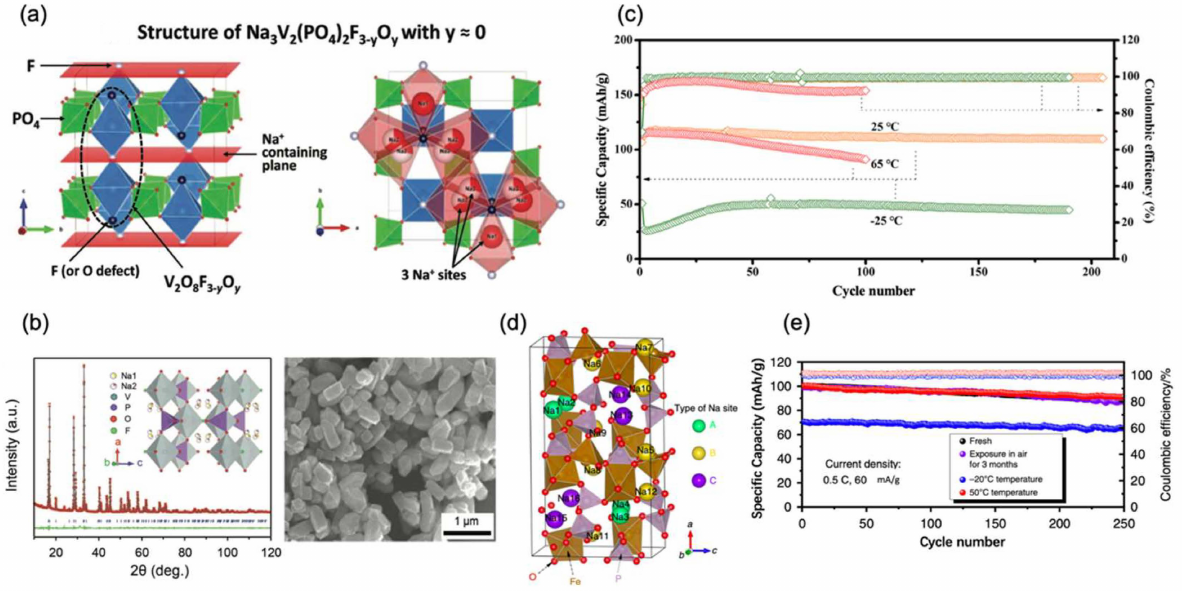
Figure 4. ( a ) On the left, the 3D schematic illustration of NVPF 3 − y O y . The black dots represent the transformation of oxygen and fluorine. The red sheet indicates Na + filling. On the right site, Na + fills into the voids of oxygen and fluorine. Reproduced with permission from Ref. [38]. Copyright 2018 WILEY-VCH. ( b ) XRD image, schematic illustration, and SEM image of NVPF-NTP material. Reproduced with permission from Ref. [39]. Copyright 2017 WILEY-VCH. ( c ) Long-term cycling performance of Na//PFSA-Na//NVOPF@rGO half-cells at a high rate of 1 C and extremely low temperatures. Reproduced with permission from Ref. [40]. Copyright 2020 Wiley-VCH. ( d ) Schematic illustration of crystal structural Na 4 Fe 3 (PO 4 ) 2 (P 2 O 7 ) material. ( e ) Long life span of 250 cycles for Na 4 Fe 3 (PO 4 ) 2 (P 2 O 7 )/C at − 20 ◦ C. Reproduced with permission from Ref. [41]. Copyright